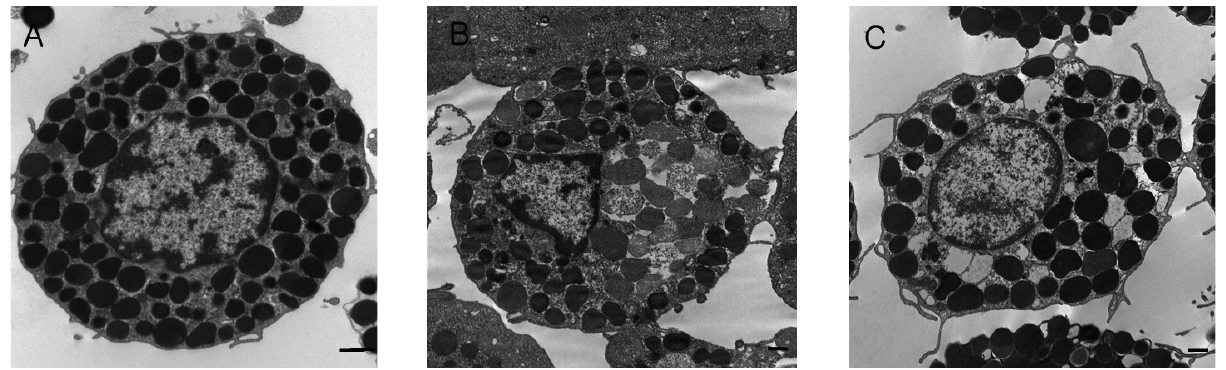
Fig. 1. – Electron microscopy of rat peritoneal mast cells (RPMC). (A) untreated RPMC, (B) & (C) RPMC treated with live trichomonads and 25 % ESP of T. vaginalis for 3 h, respectively. Typical mast cell-specific granules (granules filled with electron-dense material) are present in untreated RPMC, which were presumably exocytosed after stimulation by live trichomonad or T. vaginalis ESP. Scale bar: 0.5